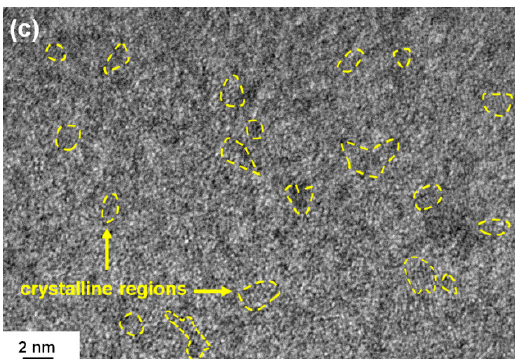
Figure 5. ( a ) Cross-sectional TEM image and selected-area diffraction pattern (SADP) of the Cr 29 Si 18 N 53 coating; ( b ) the dark field image correlated with the diffraction spot of CrN (111) in the SADP; ( c ) parts of the crystalline regions in the high-resolution TEM image (highlighted by yellow dashed lines).